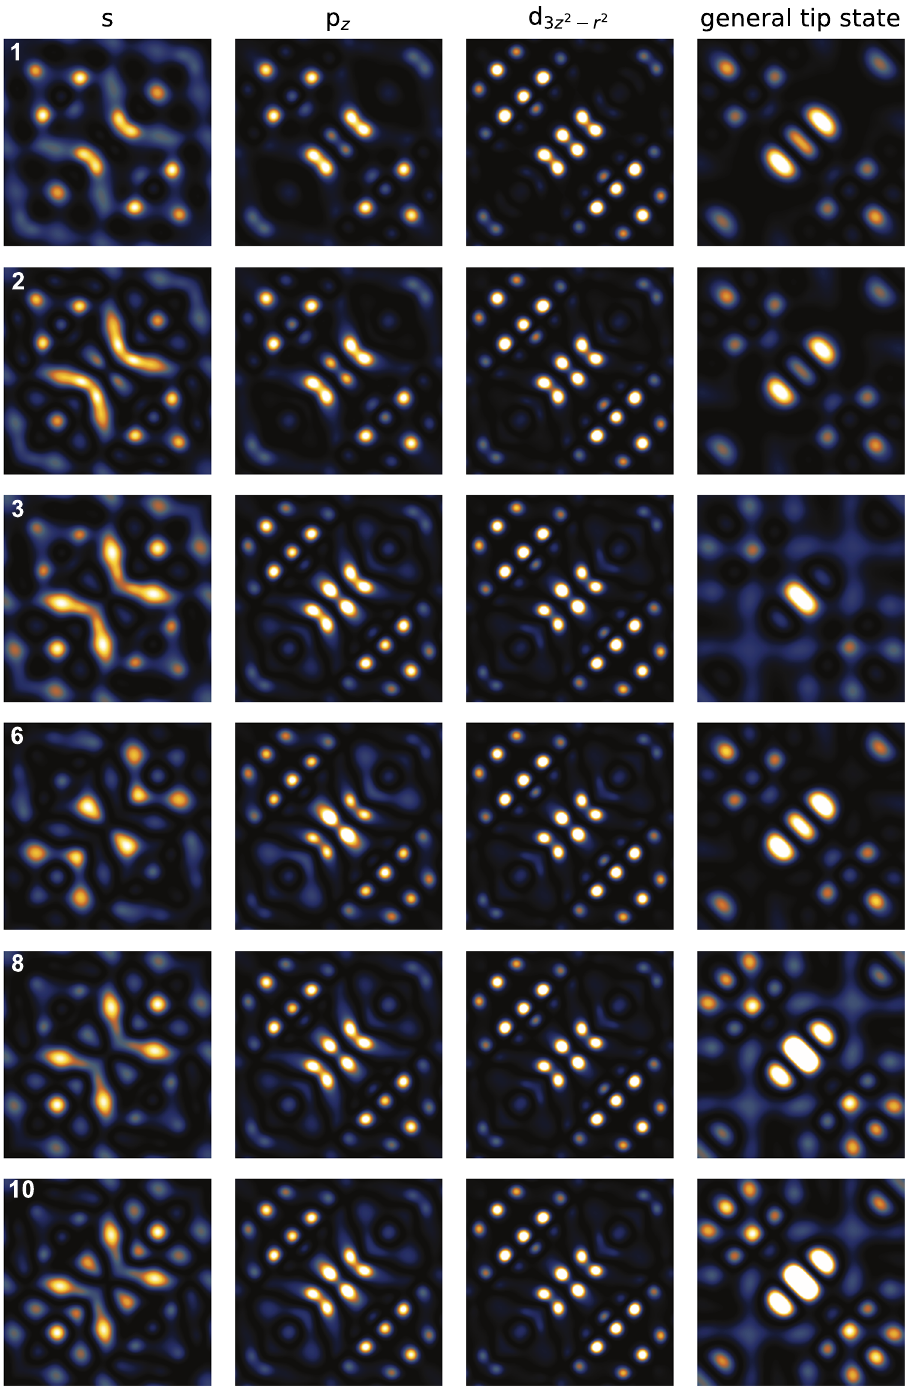
Fig. 4 Impact of different mono-layers on resulting STM image. Panels represent simulated STM images for a single P dopant at depth 4.75 a Si (20th mono-layer) for different tip orbitals (left to right). Numbers in each row denote the number of mono-layer contributions (counting from the top surface) included in the resulting image. It takes at least 10 mono-layers (bottom row) for the s-type tip image (and therefore, for the general tip state as well) to